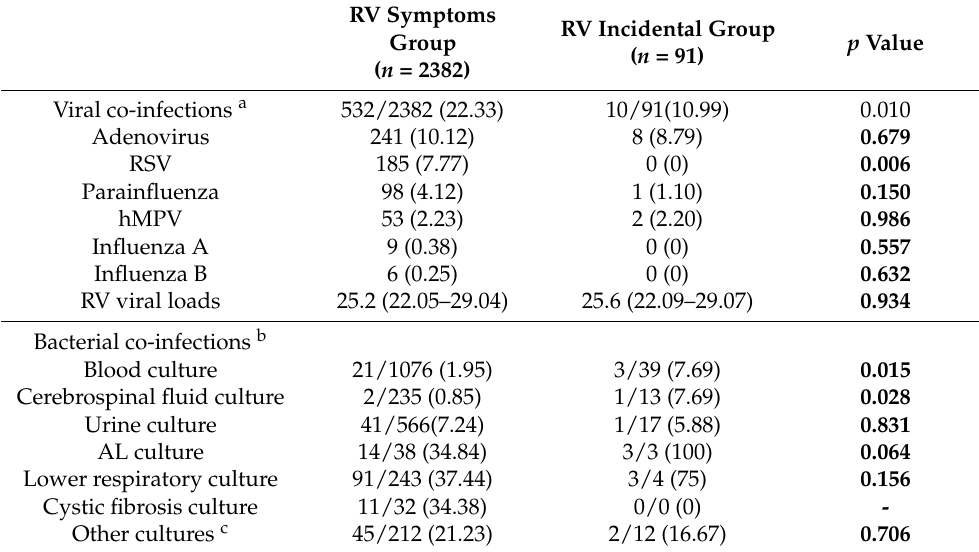
Table 4. Microbiology data of children with compatible symptoms versus incidental detection of RV.